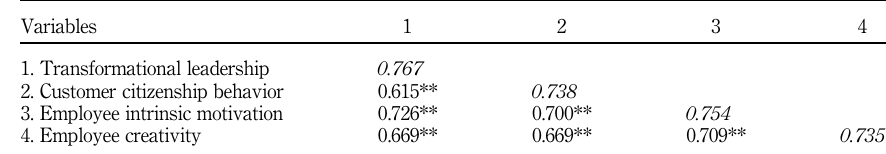
discriminant validity of the measurement model